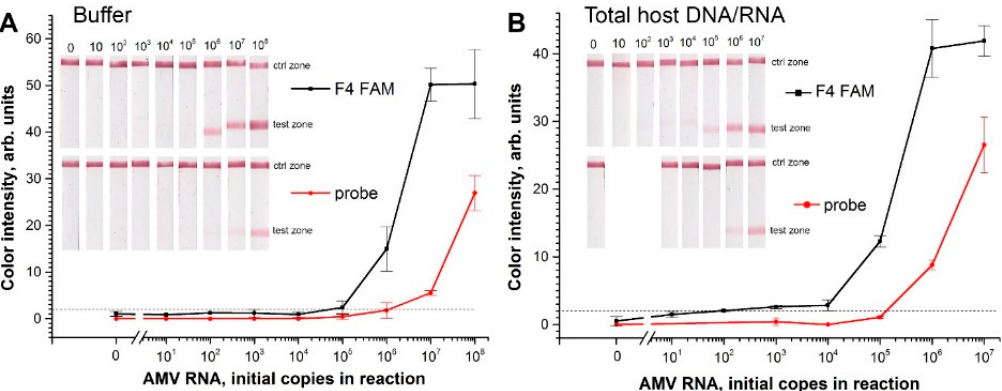
Figure 3. Dependences of RT-RPA-LFT signal from initial amount of synthetic AMV RNA3 performed by different ways of amplicon labeling: ( A ) the target RNA diluted in TE buffer; ( B ) the target RNA in potato total DNA. The black dashed line marks visibility to the eye of the signal.